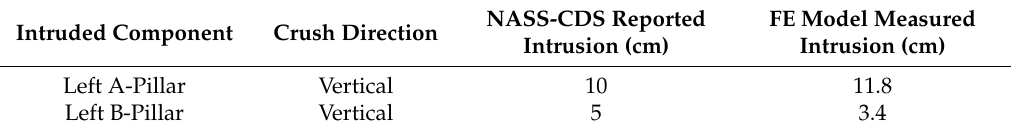
Table 5. NASS-CDS Reported Vehicle Intrusion and FE Model Measured Intrusion.